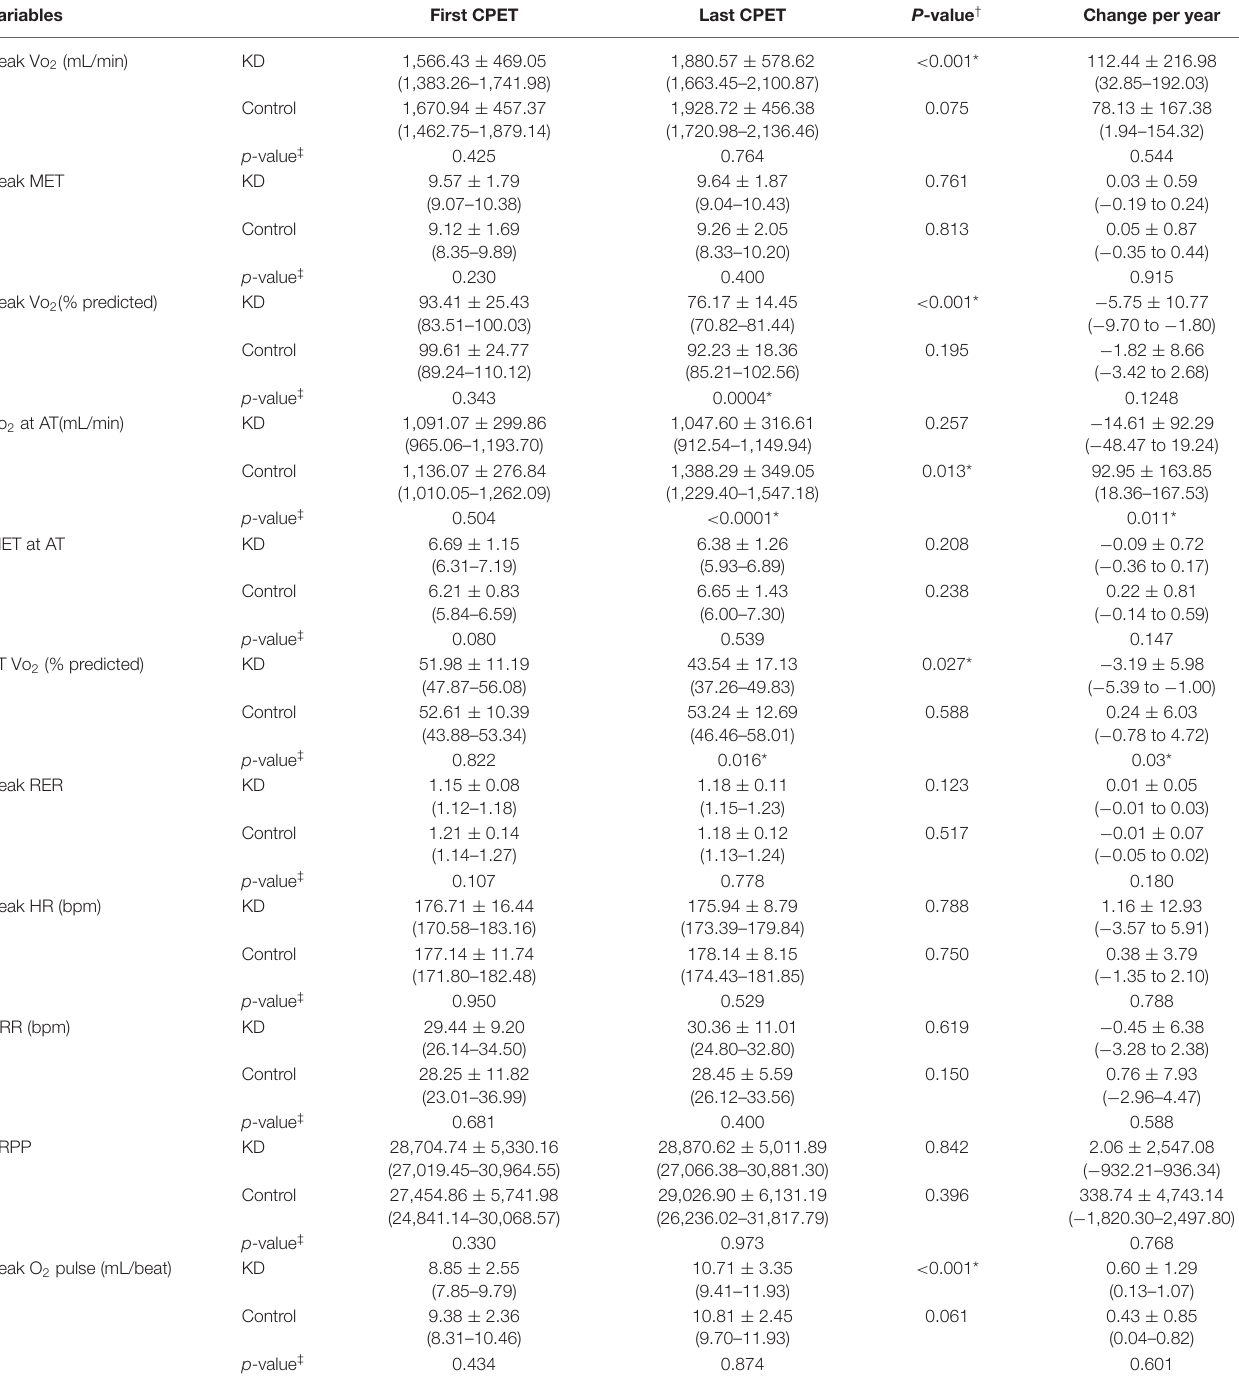
TABLE 2 | Intragroup and intergroup comparisons between the initial and the final exercise testing data in patients with Kawasaki disease and control group.